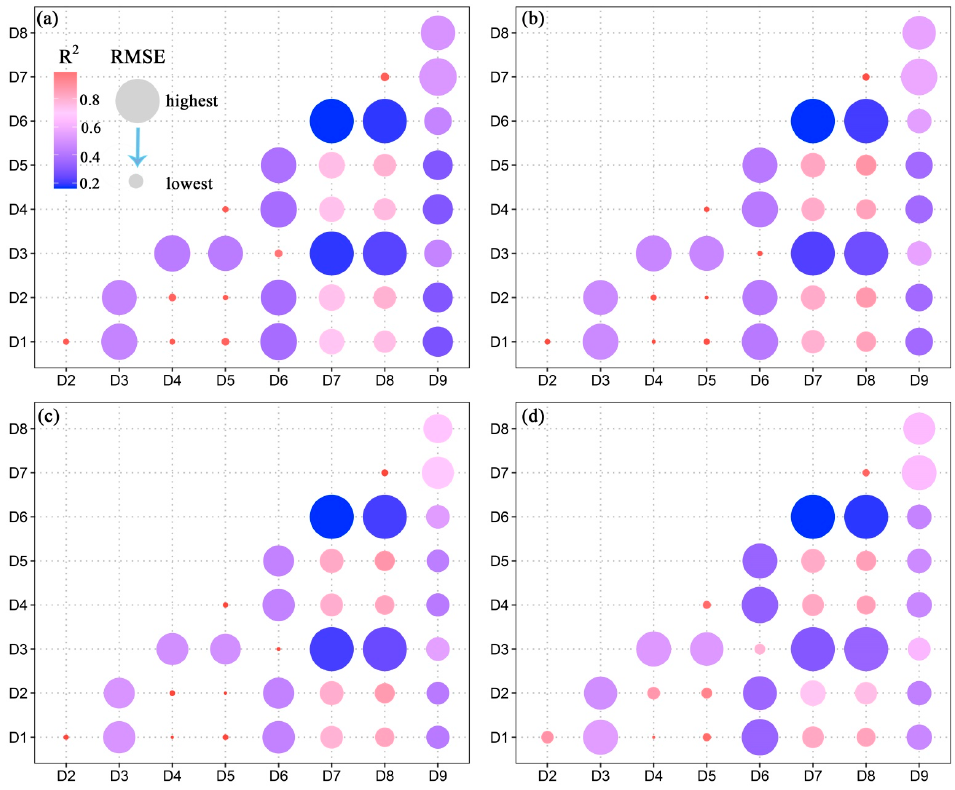
Figure 8. Linear regression results between the up-scaled SOSs at ( a ) 2 km, ( b ) 4 km, ( c ) 6 km, and ( d ) 8 km. D1 is the SOS up-scaled from the SOS derived from the 250 m AG-filtered NDVI. D2 is the SOS up-scaled from the SOS derived from the 250 m DL-filtered NDVI. D3 is the SOS up-scaled from the SOS derived from the 250 -m SG-filtered NDVI. D4 is the SOS up-scaled from the SOS derived from the 500 m AG-filtered NDVI. D5 is the SOS up-scaled from the SOS derived from the 500 m DL-filtered NDVI. D6 is the 6-km SOS up-scaled from the SOS derived from the 500 m SG-filtered NDVI. D7 is the SOS up-scaled from the SOS derived from the 1000 m AG-filtered NDVI. D8 is the SOS up-scaled from the SOS derived from the 1000 m DL-filtered NDVI. D9 is the SOS up-scaled from the SOS derived from the 1000 m SG-filtered NDVI. SG, AG is the asymmetric Gaussian filter, DL is the double logistic filter, and SG is the Savitzky-Golay fil- ter. All linear regression equations passed the F-test at a significance level of 0.001. From the above analysis, up-scaled SOSs for the 500 m SOSs are extremely similar to those from 250 m. Hence, to illustrate upscaling effects, only the 250 m and 1000 m SOSs are shown here. The up-scaled SOS datasets from 250 m and 1000 m spatial resolu- tion are shown in Figure 9 and Appendix A, Figures A1 and A2. Consistent differences are seen from these figures. For example, at the ridge, the up-scaled 1000 m resolution SOS was significantly later than the 250 m resolution SOS (Appendix A, Figures A1 and A2). The opposite behavior was observed for the slopes. Noticeable differences can also be seen in the CDF shapes at all four scales (Figure 9). In particular, the values of the up-scaled SOS from the 1000 m SOS are consistently higher than the corresponding SOS from the 250 m SOS, indicating a delayed green-up. Amongst the three filters, the SOS